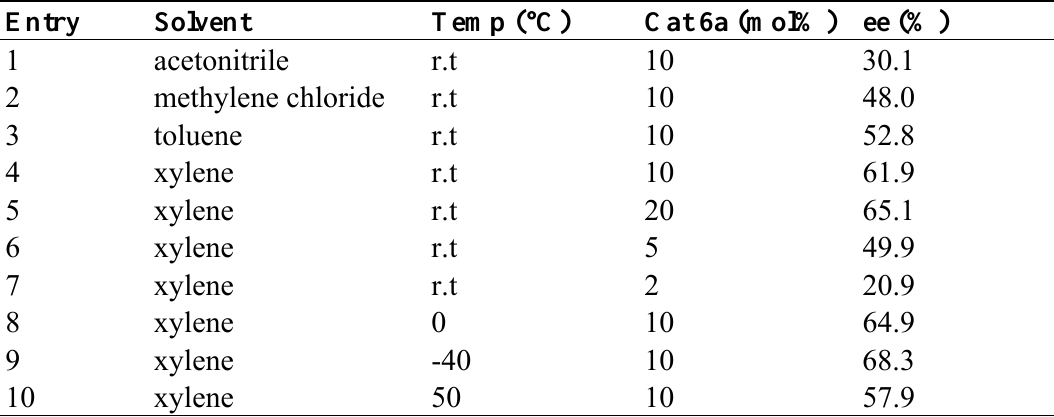
Table 4. Optimization of reaction parameters for enantioselective synthesis of 9k using chiral catalyst 6a